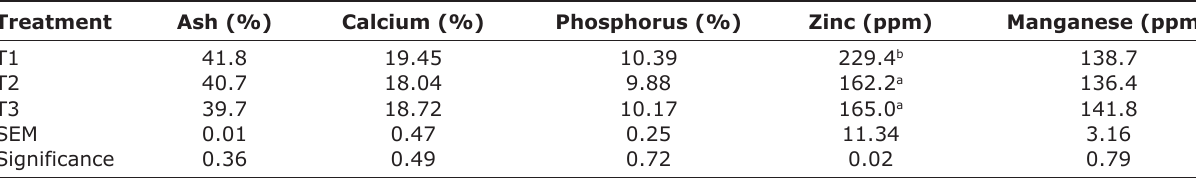
Table-6: The effect of dietary treatments on bone mineralization.